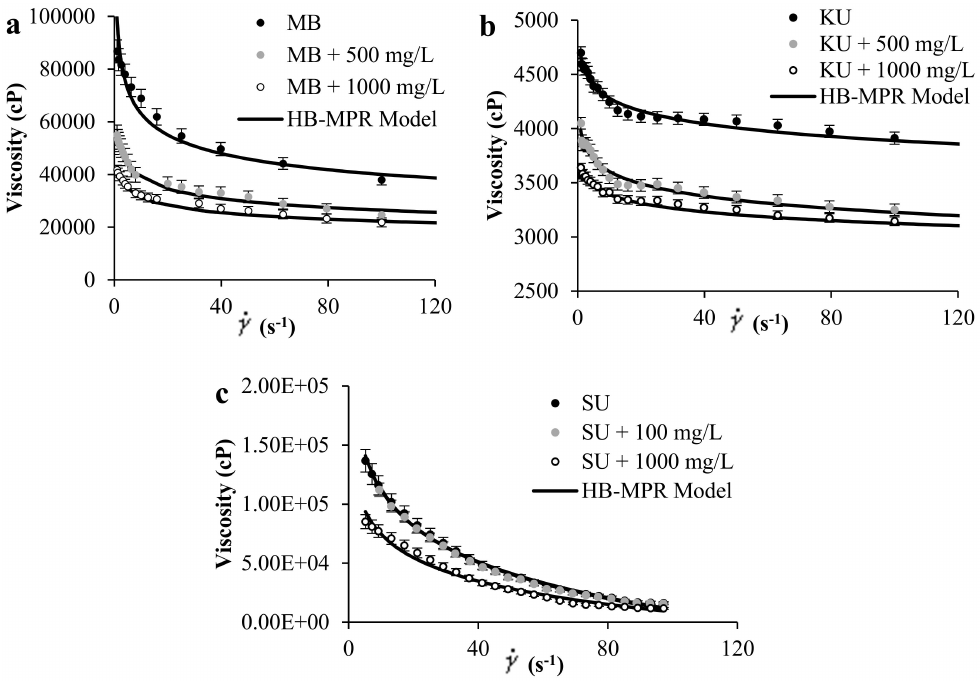
Figure 1. Viscosity of ( a ) MB heavy oil, ( b ) KU heavy oil, and ( c ) SU heavy oil, in the presence of SiO2 nanoparticles at different concentrations at 298 K and shear rate between 0 and 120 s − 1